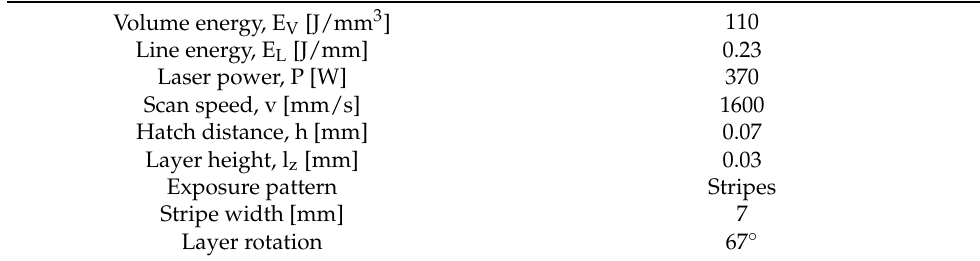
Table 2. Used infill parameter sets for Scalmalloy ® , applying the strategy time homogenization.